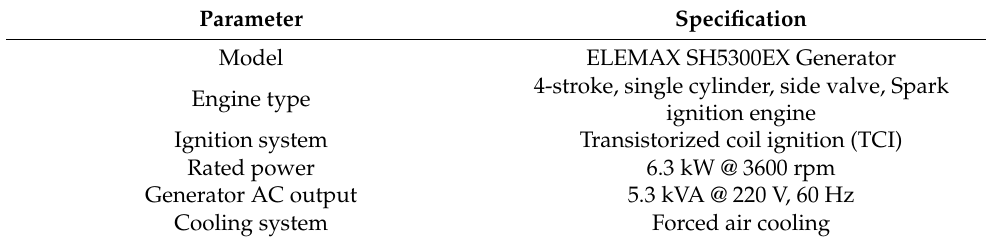
Table 4. Specifications of generator